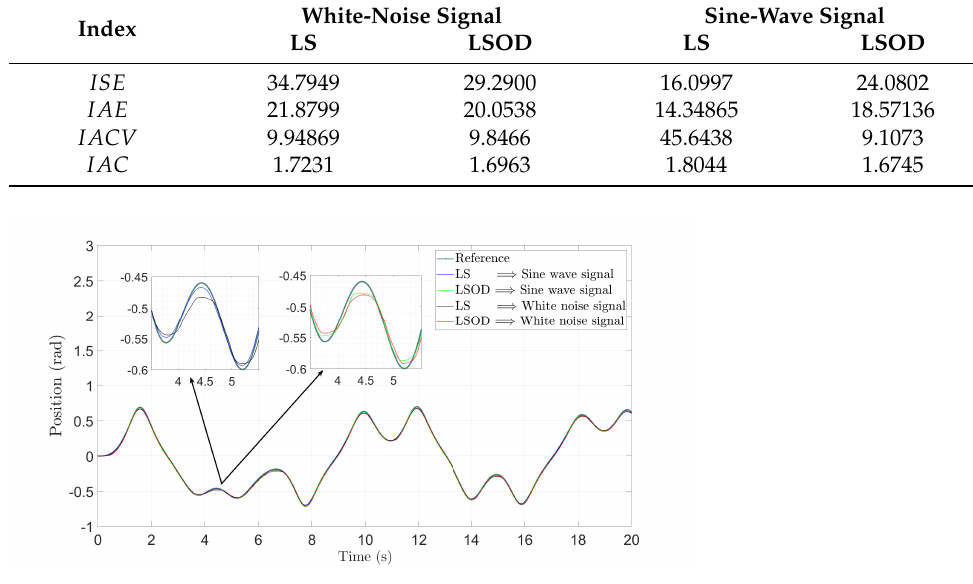
Figure 8. Reference and servo system angular positions produced by control law (61) with parameter estimates β ∗ and α ∗ . 0 1